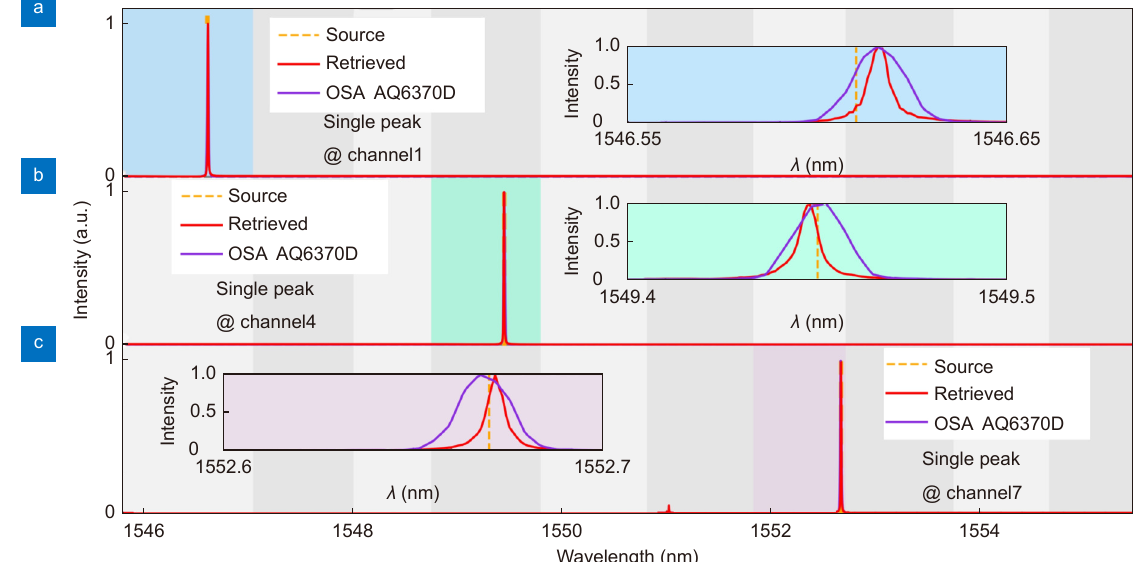
Fig. 4 | Retrieved spectrum for a given spectrum with a single peak when using the present on-chip spectrometer as well as a commer- cial OSA with a resolution of 0.02 nm. ( a ) The peak wavelength is 1546.61 nm locating at channel C 1 . ( b ) The peak wavelength is 1549.45 nm locating at channel C 4 . ( c ) The peak wavelength is 1552.67 nm locating at channel C 7